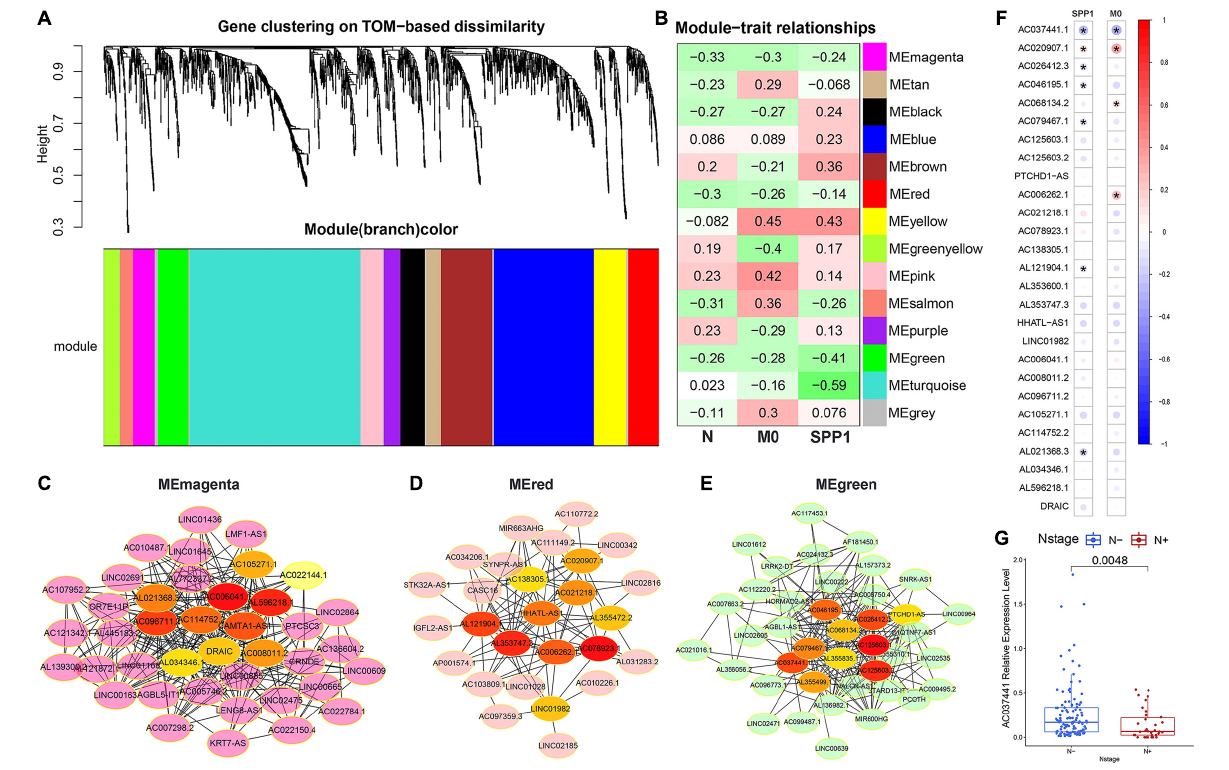
FIGURE 7 | Identification of long non-coding RNAs (lncRNAs) associated with early lymph node metastasis, SPP1 expression, and M0 infiltration. (A) Hierarchical clustering analysis was performed to determine the lncRNA co-expression modules represented by different colors. (B) The heatmap was used to demonstrate the correlation between the modules and lymph node metastasis, SPP1 expression, and M0 infiltration. (C–E) The top 10 hub lncRNAs and their first-level nodes of 3 key modules (“MEmagenta,” “MEred,” and “MEgreen”) were identified through the maximal clique centrality (MCC) algorithm (the color of the hub nodes represented the hub level, red is the highest, and followed by orange). (F) The correlation analysis of 30 hub lncRNAs with SPP1 expression and M0 infiltration is based on TCGA dataset. (G) Expression level analysis of lncRNA (AC037441) between the lymph node metastasis group and the non-metastatic group in TCGA cohort. * p <